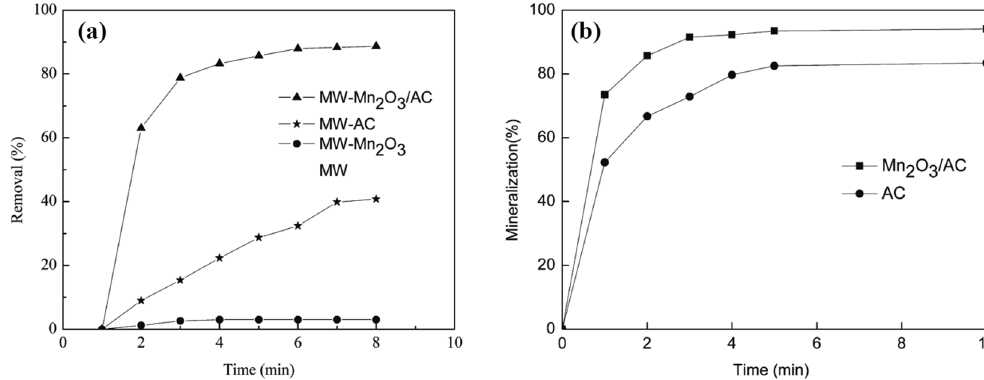
Figure 3. Effect of different catalysts on the degradation of 4-NP: ( a ) Removal; ( b )